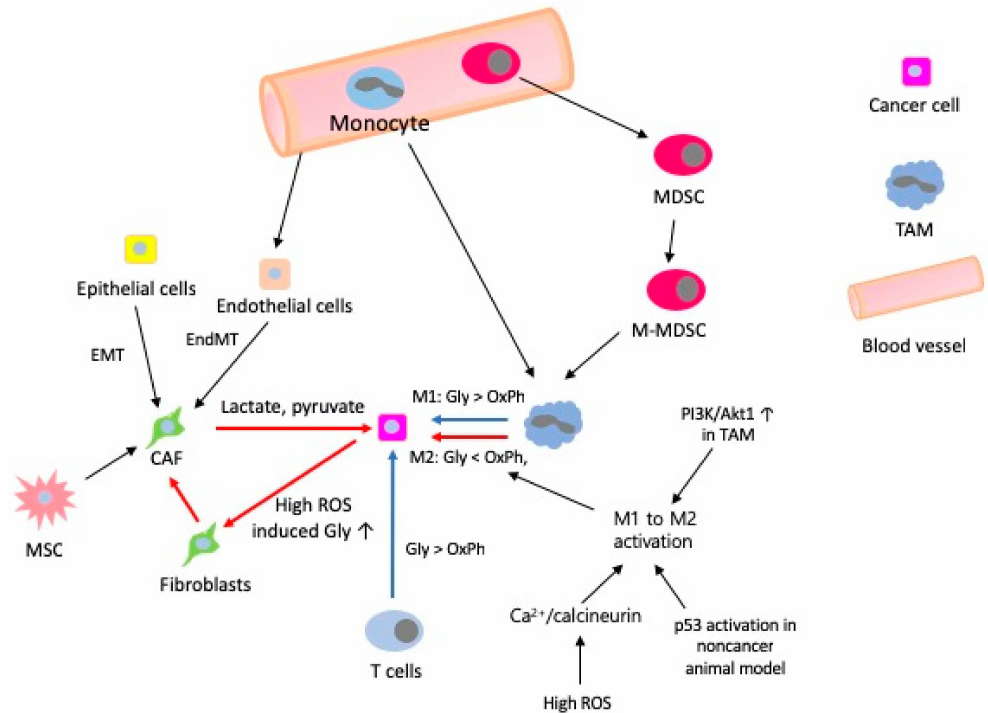
Figure 3. Summary of metabolic switching in the TME. Red arrows indicate immune suppressive response favourable to growth and survival of cancer cells. Blue arrows indicate immune stimulatory response detrimental to cancer cells. Abbreviations: EndMT, endothelial to mesenchymal transition; Gly, aerobic glycolysis; MDSC, myeloid derived suppressor cell; M-MDSC, monocytic myeloid derived suppressor cell; OxPh, oxidative phosphorylation; TAM, tumour-associated